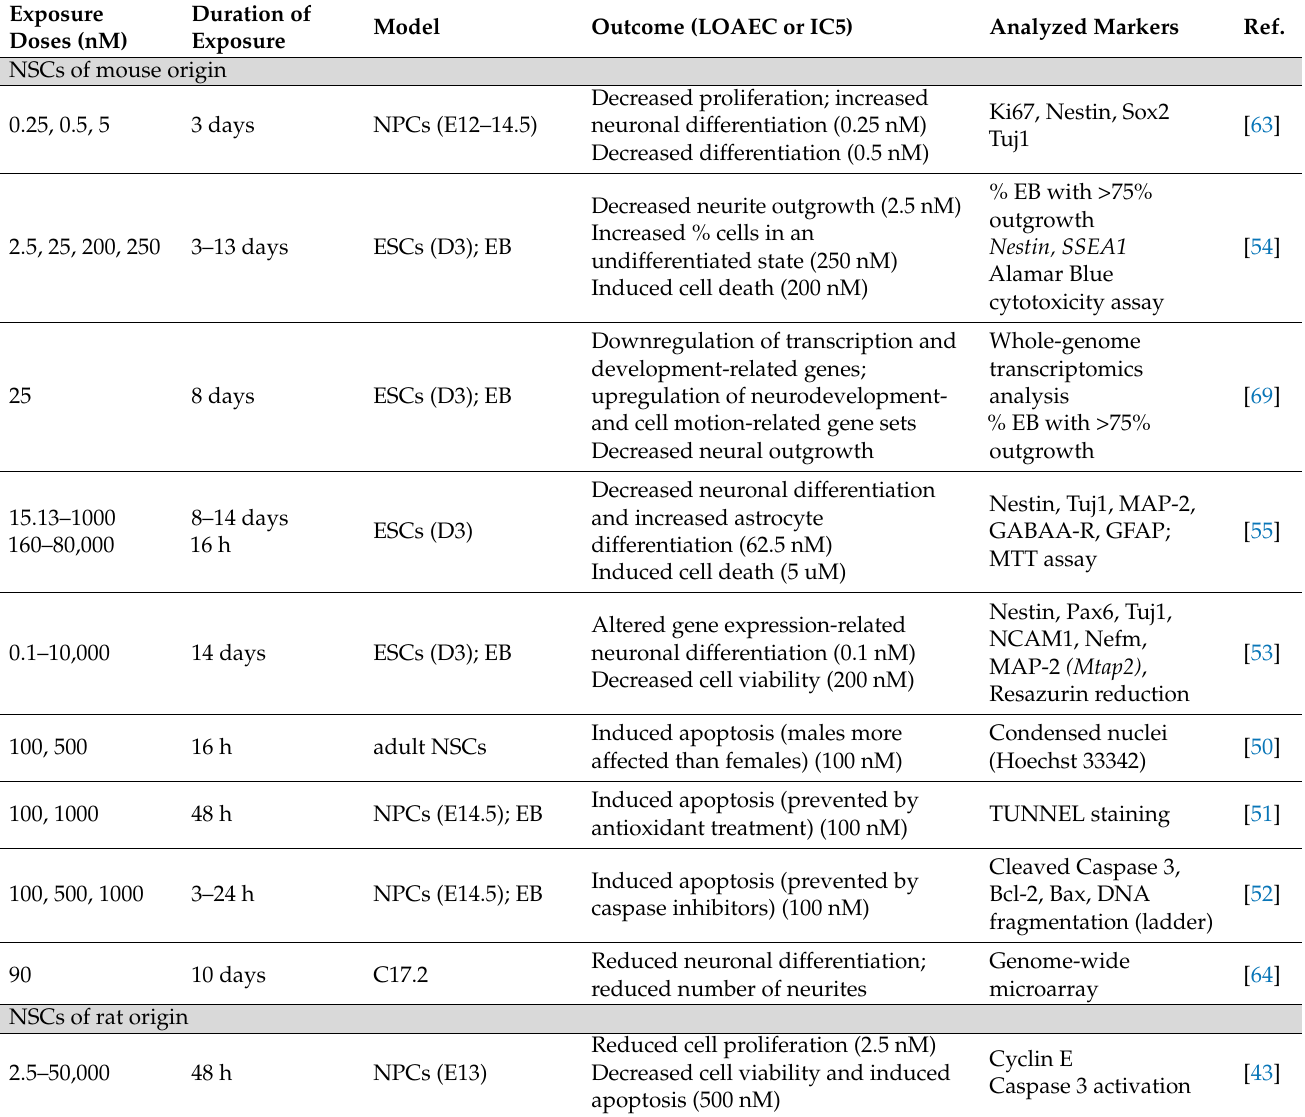
Table 1. Studies reporting the effects of MeHg exposure in